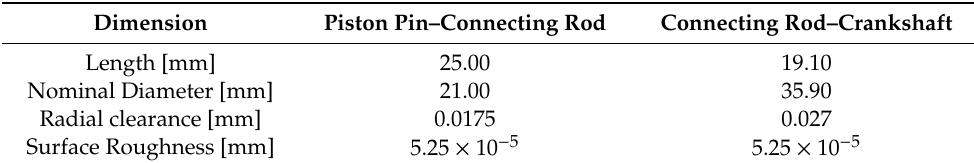
Table 6. Geometric characteristics of the joints studied.